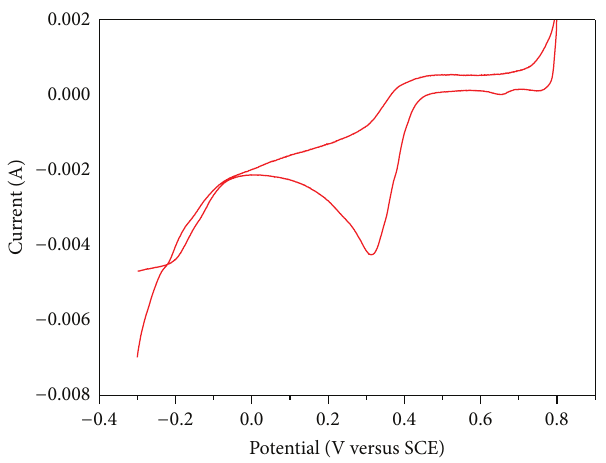
Figure 6: Cyclic voltammogram response of AuNPs-chi- graphene/gold electrode to 200 𝜇 M Cr(VI) in 0.1M HCl (scan rate = 50 mVs −1 ).